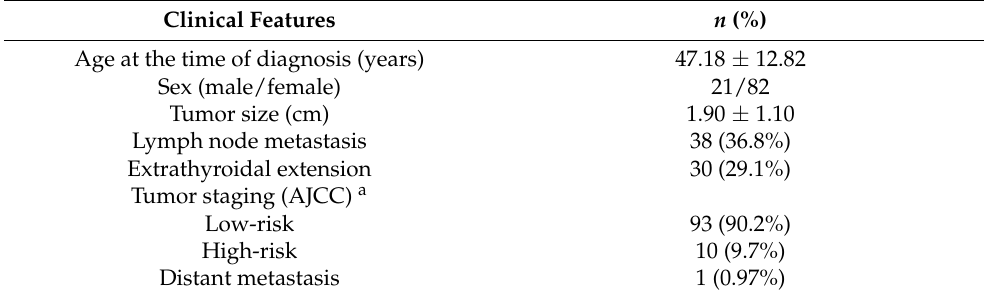
Table 1. Clinicopathological features of the papillary thyroid carcinoma (PTC) cases examined in this study ( n =